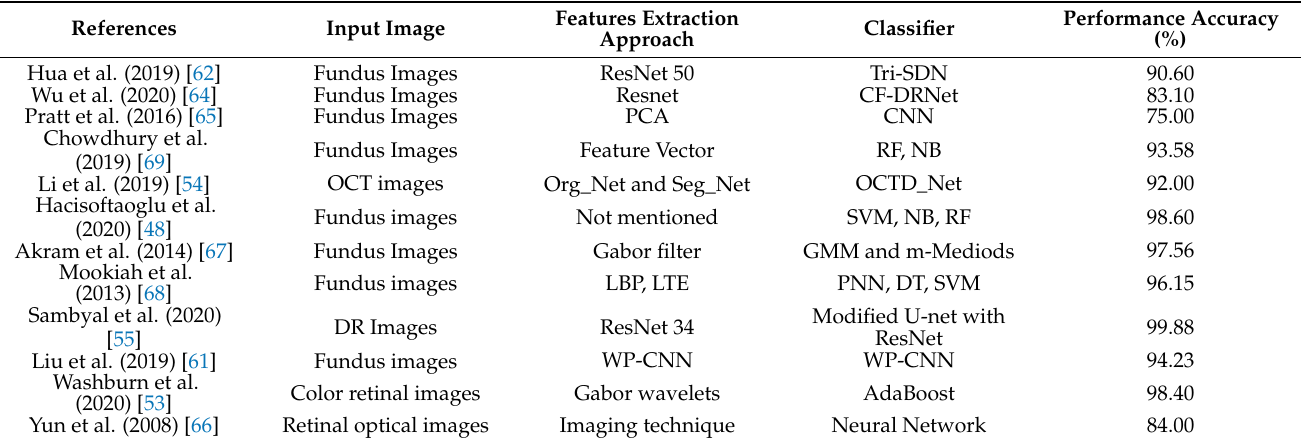
Table 2. Performance analysis of some diabetic retinopathy identification